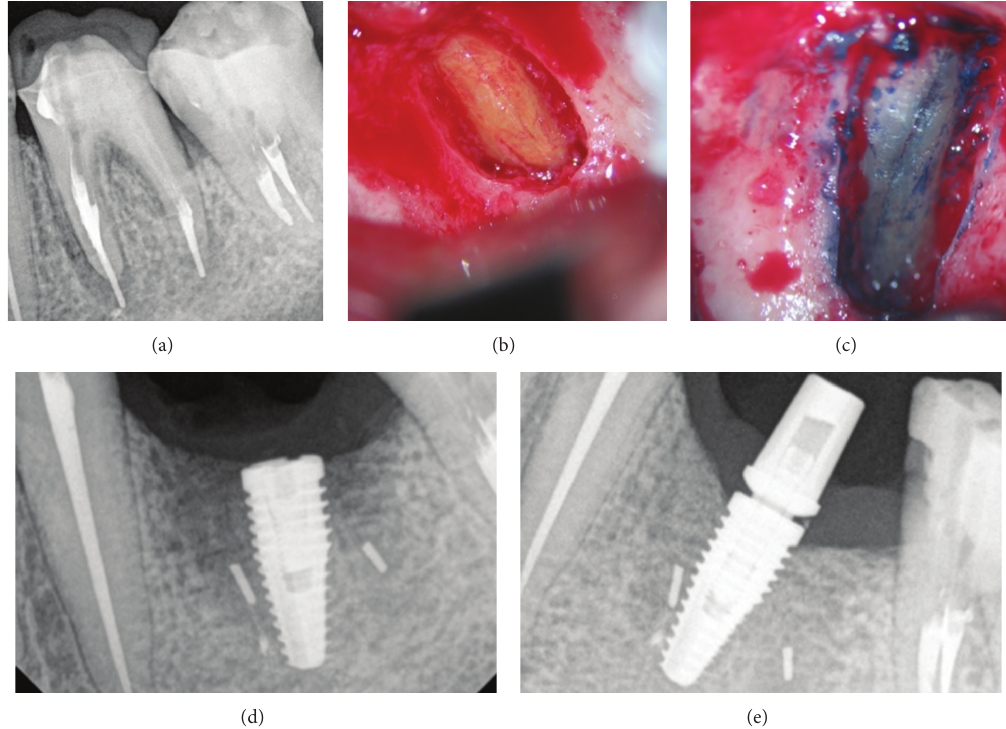
Figure 1: Initial radiograph of the first molar. Observe the extravasation of the filling material in the mesial root (a). Clinical aspect of the mesial root showing the vertical root fracture and bone fenestration (b). Application of dye (SableSeek, Ultradent) confirming the presence of RVF (c). Radiograph aspect after immediate implant placement (Neodent, 10.0×4.3 ) (d). Radiograph aspect 4 months after the immediate implant installation with the placement of temporary crown